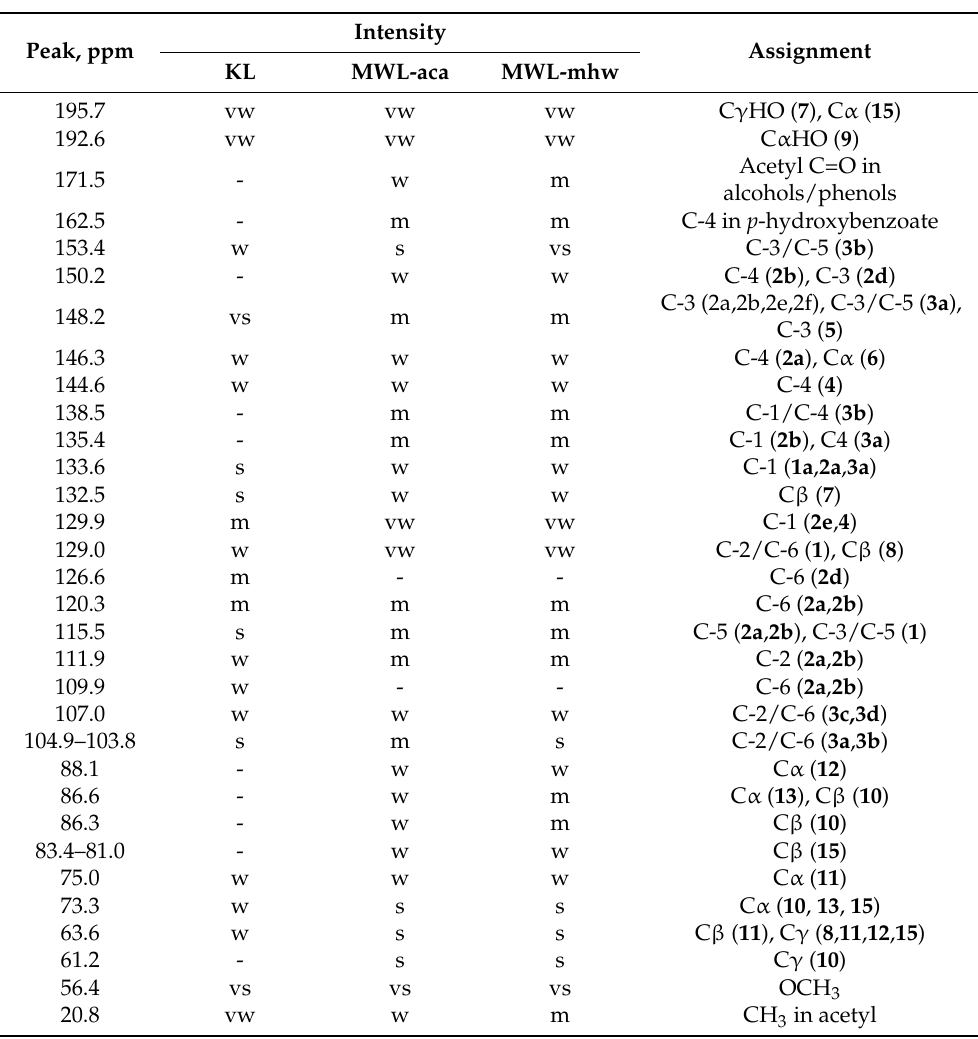
Table 8. 13 C NMR assignment of KL and MWLs. Peak,